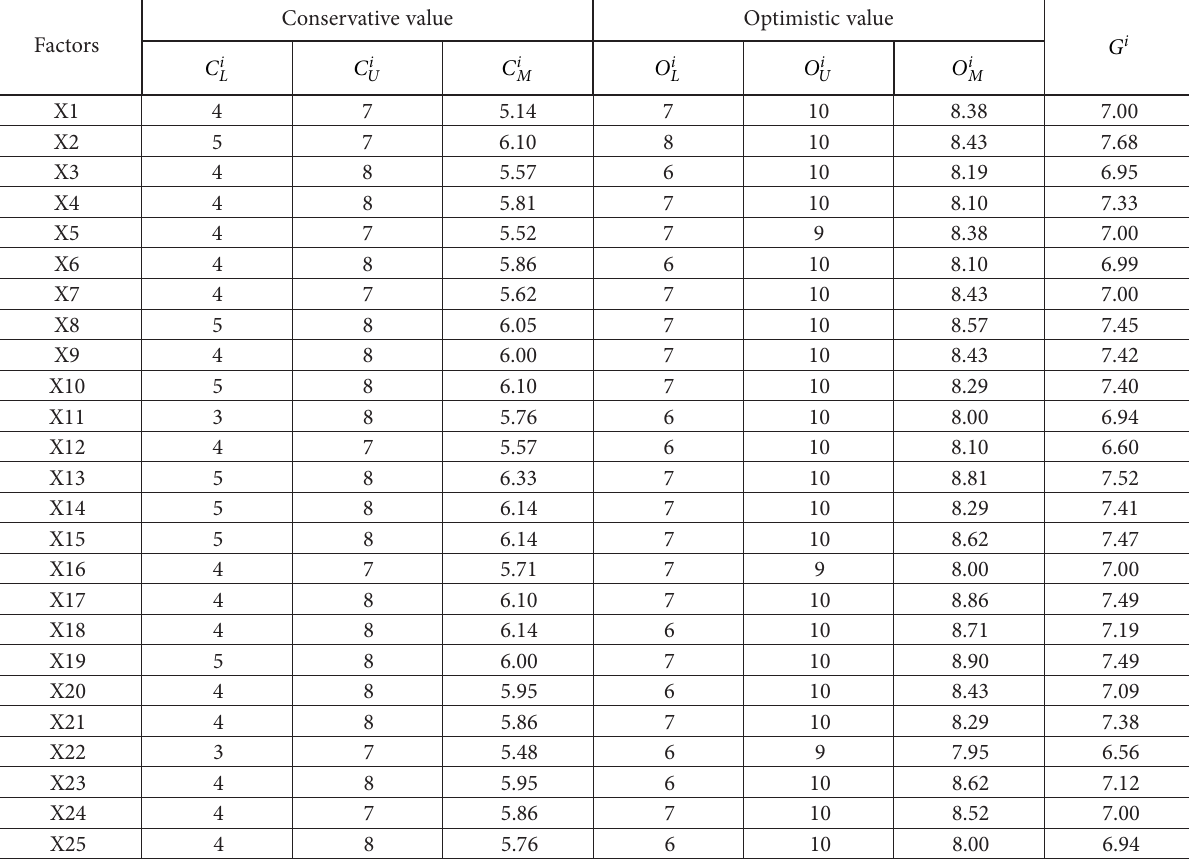
Table 3. Analysis of the FDM